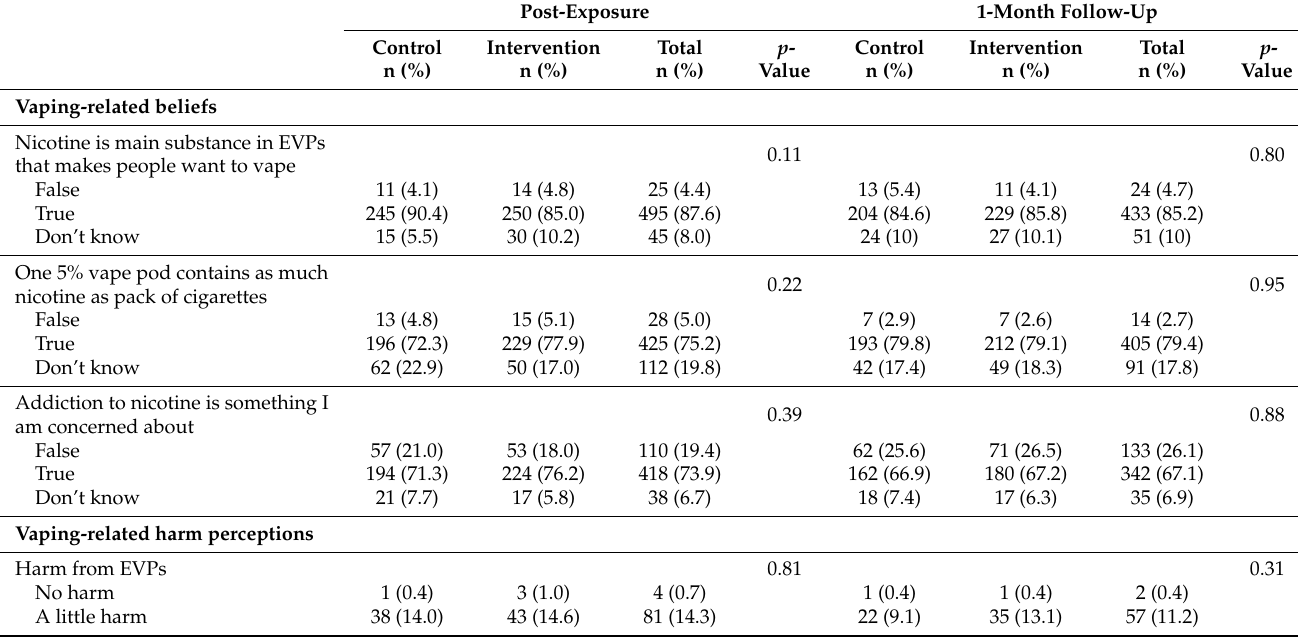
Table 3. Effect of study condition on vaping-related beliefs, harm perceptions and norms immediately post-exposure and at 1-month follow-up, PACE Vape Messaging Study,